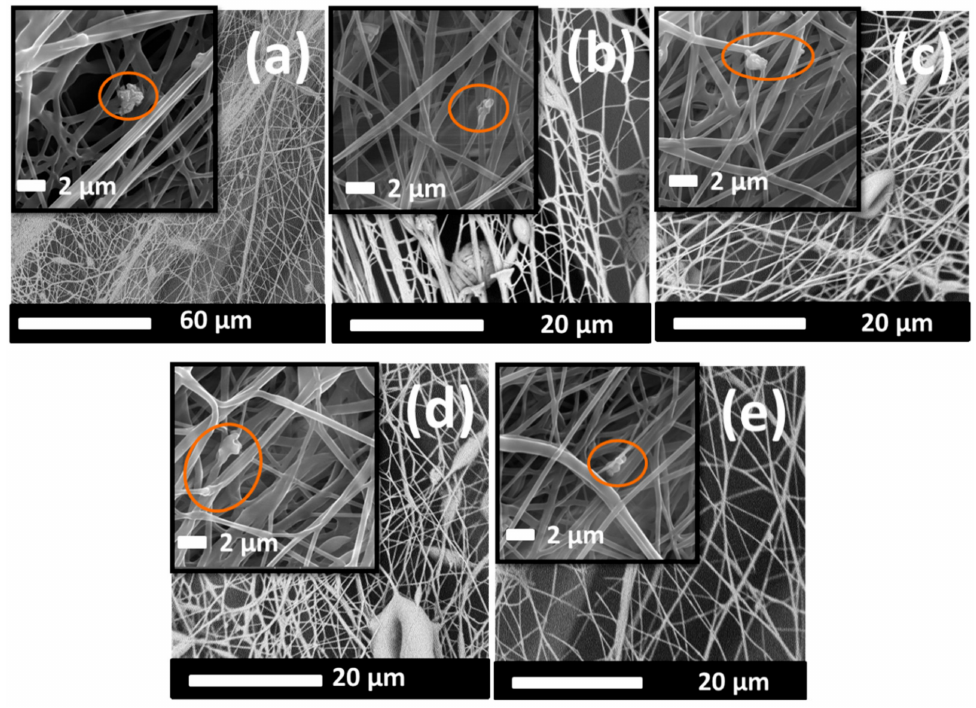
Figure 2. SEM images of ( a ) PC_5_100, ( b ) PC_10_100, ( c ) PC_5_150, ( d ) PC_10_150, and ( e ) PC_5_200. Nanoparticles are indicated in the